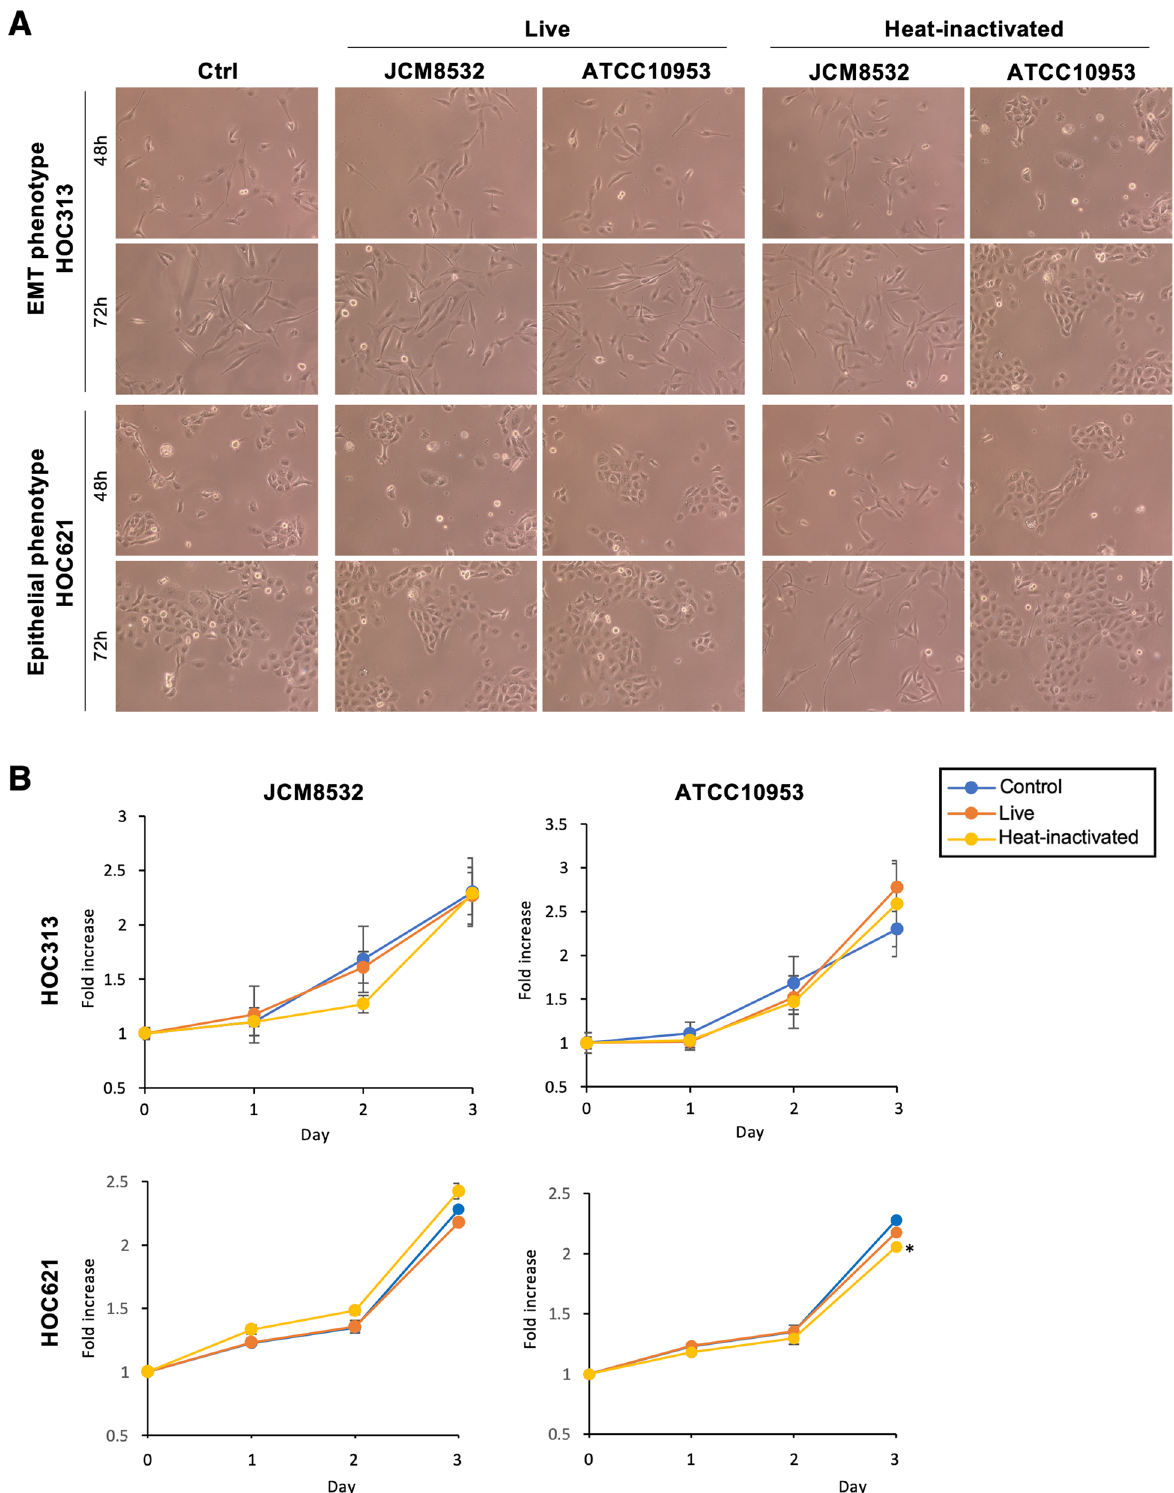
Figure 3. Cell morphology and proliferation in OSCC cells after co-culture with F. nucleatum . ( A ) Morphological images of OSCC cells after co-culture with F. nucleatum for 48 and 72 h. HOC313 and HOC621 were co-cultured with live or heat-inactivated F. nucleatum (JCM8532 and ATCC10953, MOI = 10). ( B ) Cell proliferation of HOC313 and HOC621 cells after co-culture with live or heat-inactivated F. nucleatum (JCM8532 and ATCC10953, MOI = 10). The graphs show the results as mean ± S.D. of three independent experiments. (*) represents P -value of < 0.05 compared to control (no